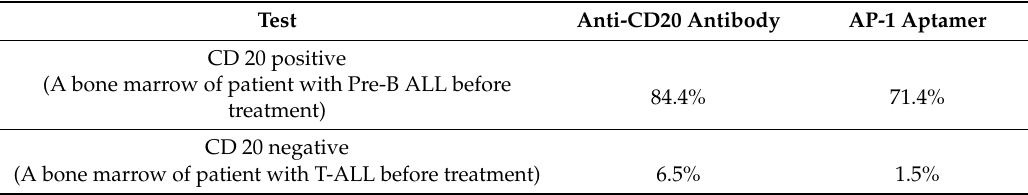
Figure 5. The flow cytometry evaluation of AP-1 aptamer with a negative sample (no expressed CD20) and positive sample (expressed CD20) to compare aptamer and monoclonal antibody. ( A ) the flow cytometric analysis of CD20 expression by Anti-CD20 Antibody incubated with immature bone marrow cells of patient with Pre-B ALL; ( B ) the flow cytometric analysis of CD20 expression by AP-1 aptamer with immature bone marrow cells of patient with Pre-B ALL; ( C ) the flow cytometric analysis of CD20 expression by Anti-CD20 Antibody incubated with immature bone marrow cells of patient with T-ALL; ( D ) the flow cytometric analysis of CD20 expression by AP-1 aptamer incubated with immature bone marrow cells of patient with T-ALL. The comparative results of monoclonal anti-CD20 antiboby and AP-1 aptamer for two patients with Pre-B ALL and T-ALL with and without expressing CD20 as positive and negative control,